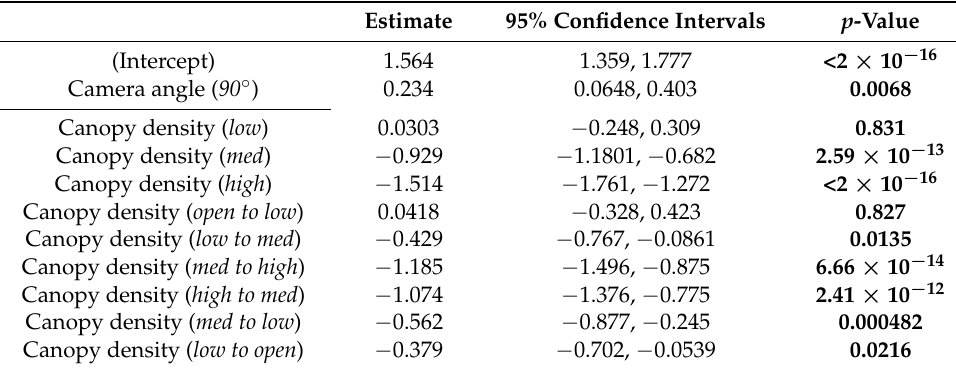
Table 4. The model with the best fit to the data for TIR images with automated detection includes the variables camera angle and canopy density. Estimate 95% Confidence Intervals p